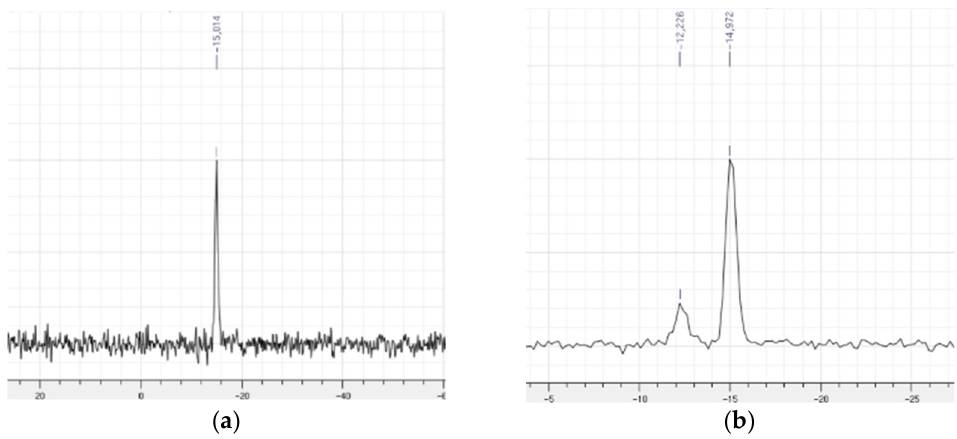
Figure 3. Solid ‐ state 31 P NMR of MR 4 ‐ W ( a ) and MR 12 ‐ W ( b ) supported catalysts. Figure 3. Solid-state 31 P NMR of MR 4 -W ( a ) and MR 12 -W ( b ) supported catalysts.